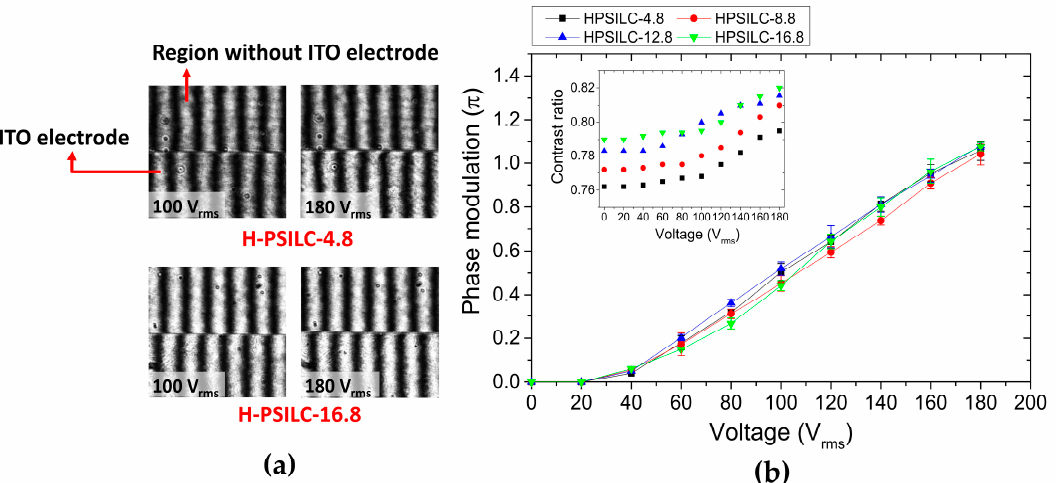
Figure 5. ( a ) Shift of interference patterns occurring in the boundary with or without ITO electrode in both H-PSILC-4.8 and H-PSILC-16.8 cells with applied voltages of 100 and 180 V rms ; ( b ) Electric phase modulation in PSILC cells with various percentages of S811 chiral dopant. Insert shows CR values with respect to the applied voltages.